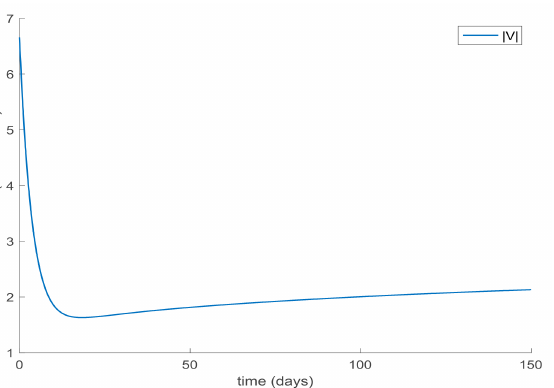
Figure 6. Vaccination applied when a constant term of the susceptible individuals is vaccinated (20%) and β is given by Figure